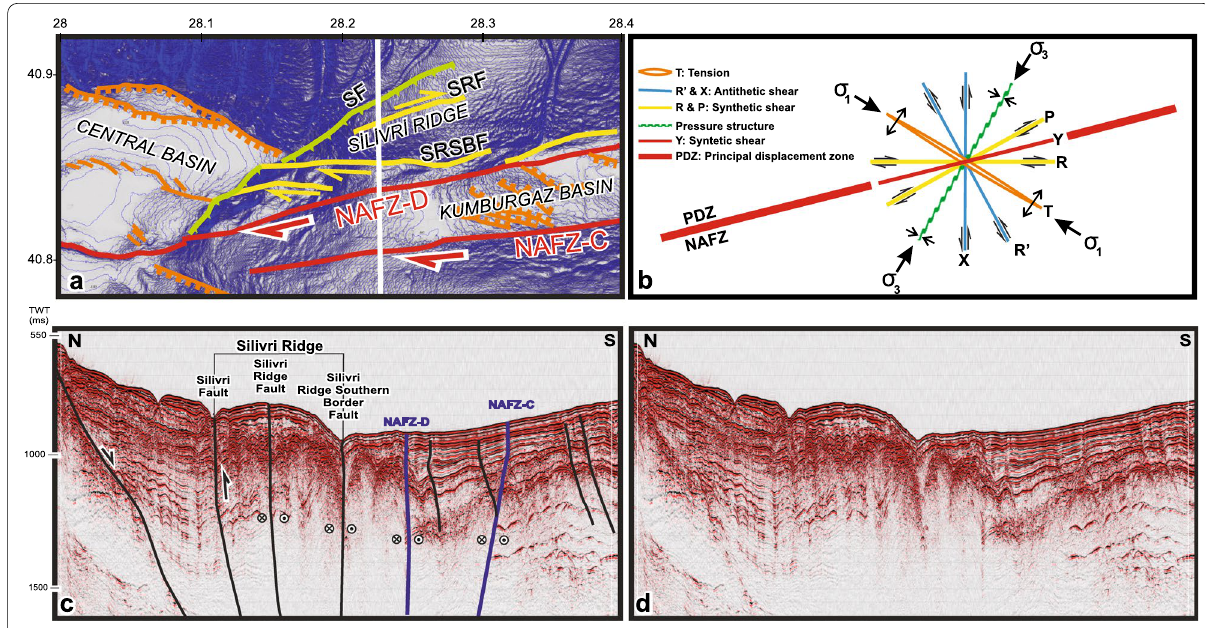
Fig. 4 a Morphotectonic structure and fault system of the study area. NAFZ-C and NAFZ-D are C and D segments of the northern branch of the NAFZ, SF Silivri Fault, SRF Silivri Ridge Fault, SRSBF Silivri Ridge Southern Border Fault. b Dextral strike-slip system deformation model and directions of the active structures (Tchalenko 1970; Sylvester 1988). The colors in the model indicate the faults with the same characteristics as the fault on the map. c and d Interpreted and uninterpreted multichannel seismic reflection profile showing the main fault segments and secondary faults associated with the Silivri earthquakes (also see Additional file 1: Figure S3; profile adopted from Steckler et al. (2018)). The seismic reflection profile shown in this figure is displayed for up to 1.6 s (TWT), because when the entire profile is viewed for up to 5 s, the resolution of the profile